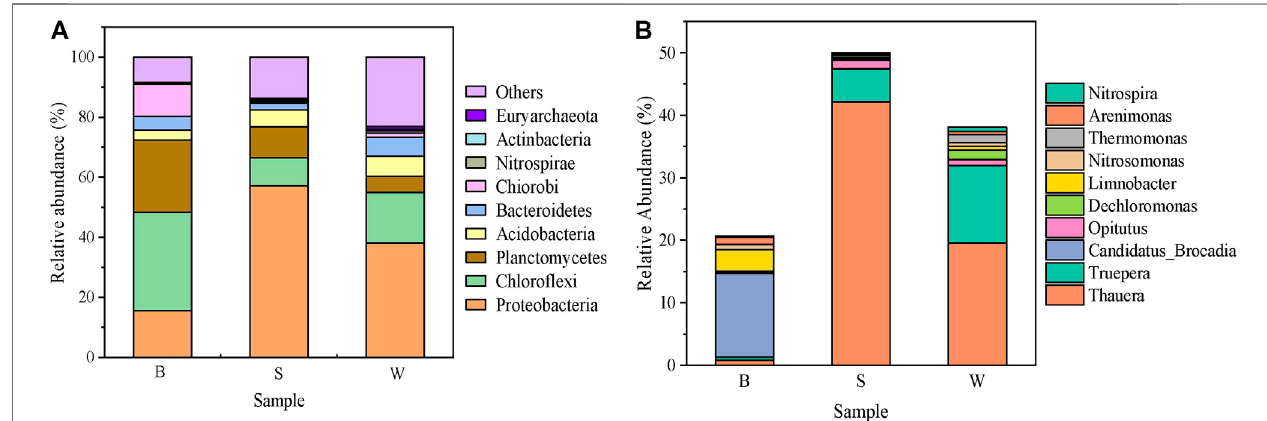
FIGURE 4 | Distribution of microbes at the phylum (A) and genus (B)